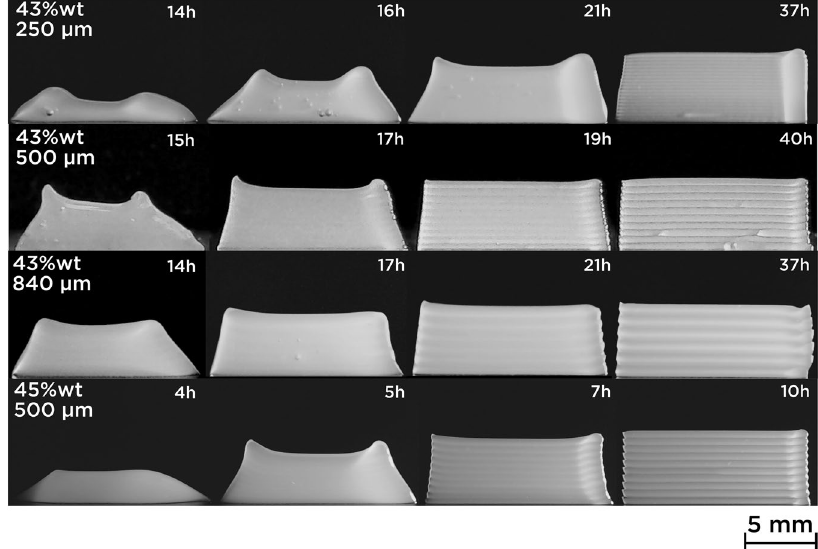
Figure 6. 5 mm stacks of 43 wt% and 45 wt% boehmite suspensions printed with 250, 500 and 840 μ m nozzles at 3 mm . s − 1 after different aging times. 45 wt% suspension became printable earlier than 43 wt%, whatever than nozzle size is. Nozzle size also impacts the printability as comparable aging times lead to different results with the same suspension. With a σ yDyn of 200 Pa, 5 h-45 wt% object clearly confirms that yield stress is not a sufficient